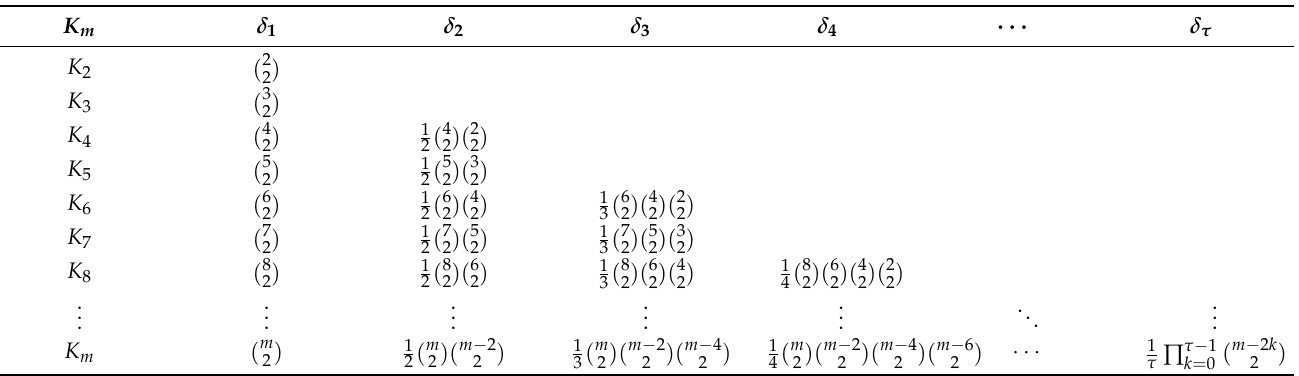
Table 5. Non-empty K m